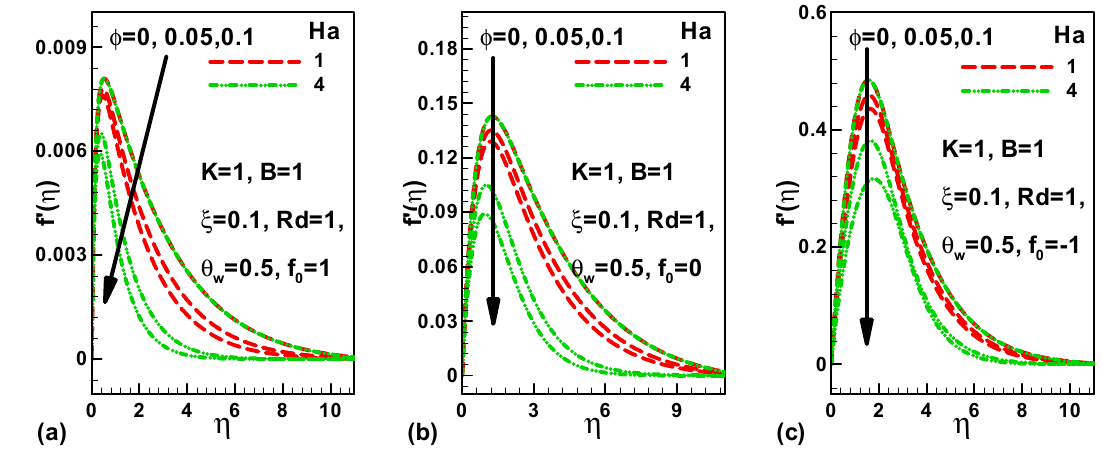
Figure 5. Effects of magnetic parameter and solid volume fraction of nanoparticles on dimensionless velocity along truncated cone for ( a ) suction, ( b ) impermeable, and ( c ) injection of kerosene-based magnetite nanofluid.